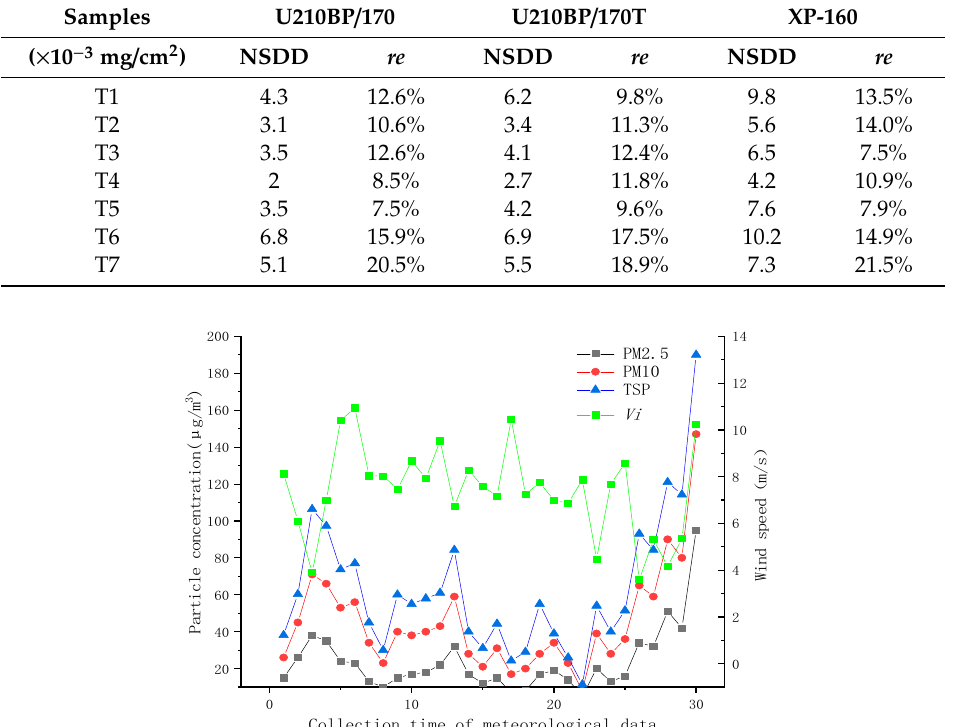
Table 2. Tests result and calculated re.